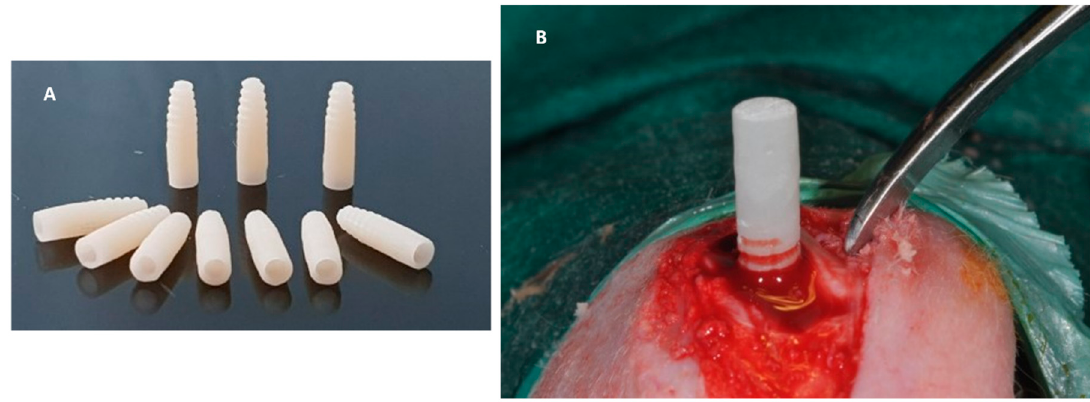
Figure 12. PMMA and GD-PMMA before and during placement in the bone